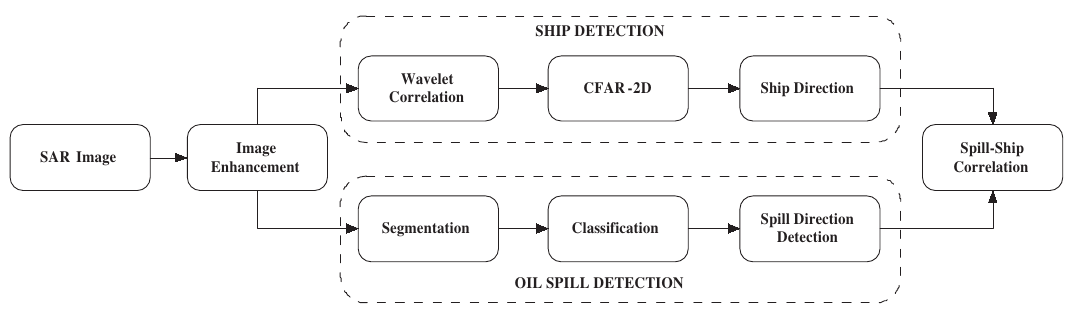
Figure 1. Algorithm